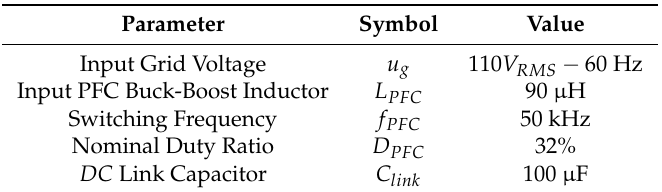
Table 1. Input PFC Stage Parameters.